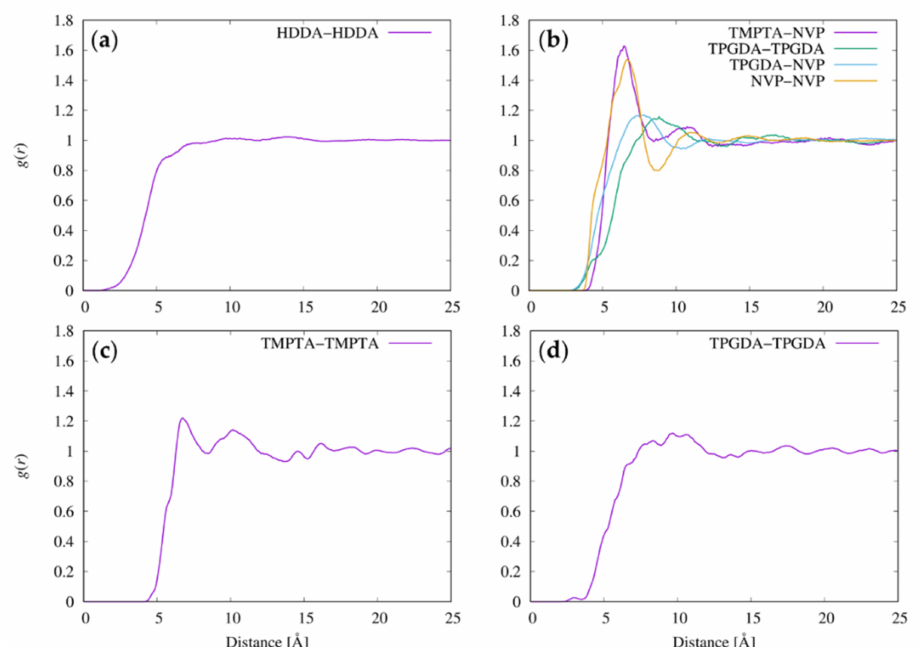
Figure 6. Pair radial distribution function, g ( r ), between the centers of masses of the resist molecules: ( a ) HDDA in resist I, ( b ) various molecule pairs in resist II, ( c ) TMPTA in resist III, and ( d ) TPGDA in resist